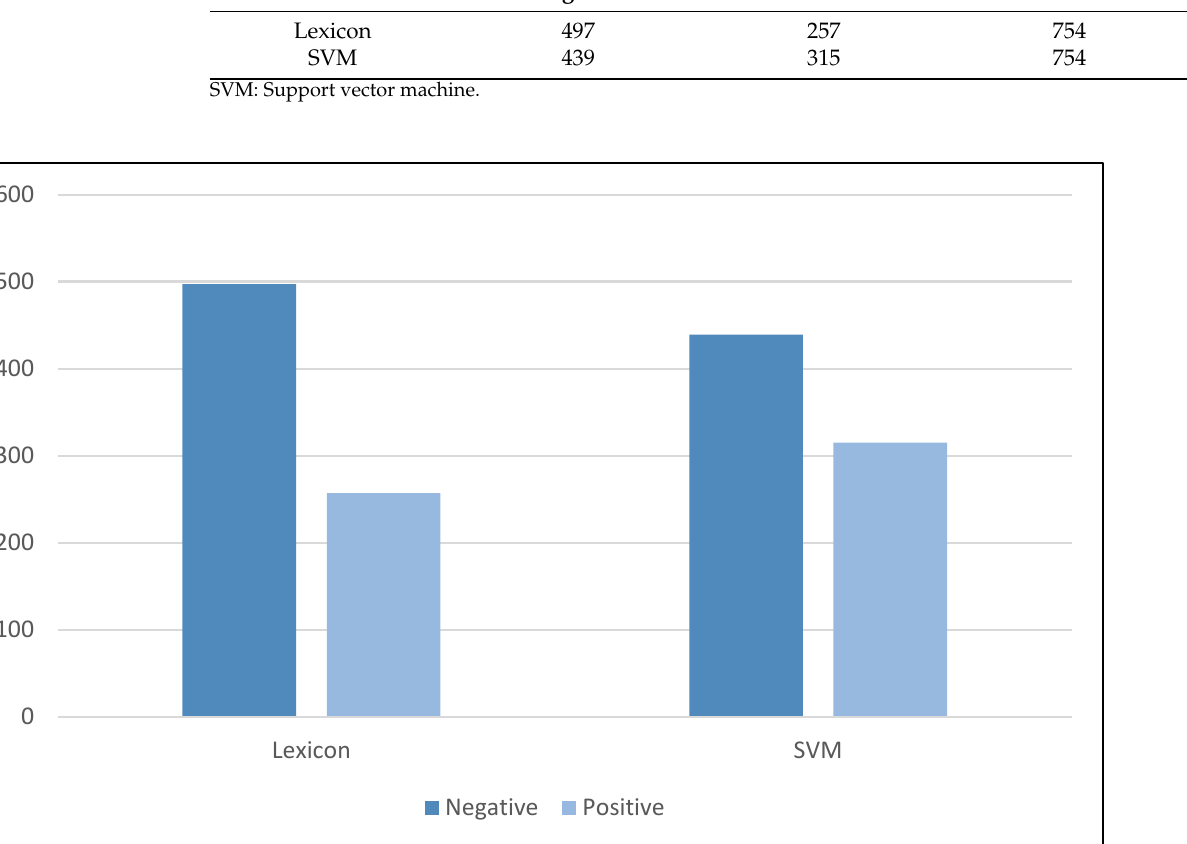
Table 7. Random preview of polarity results.